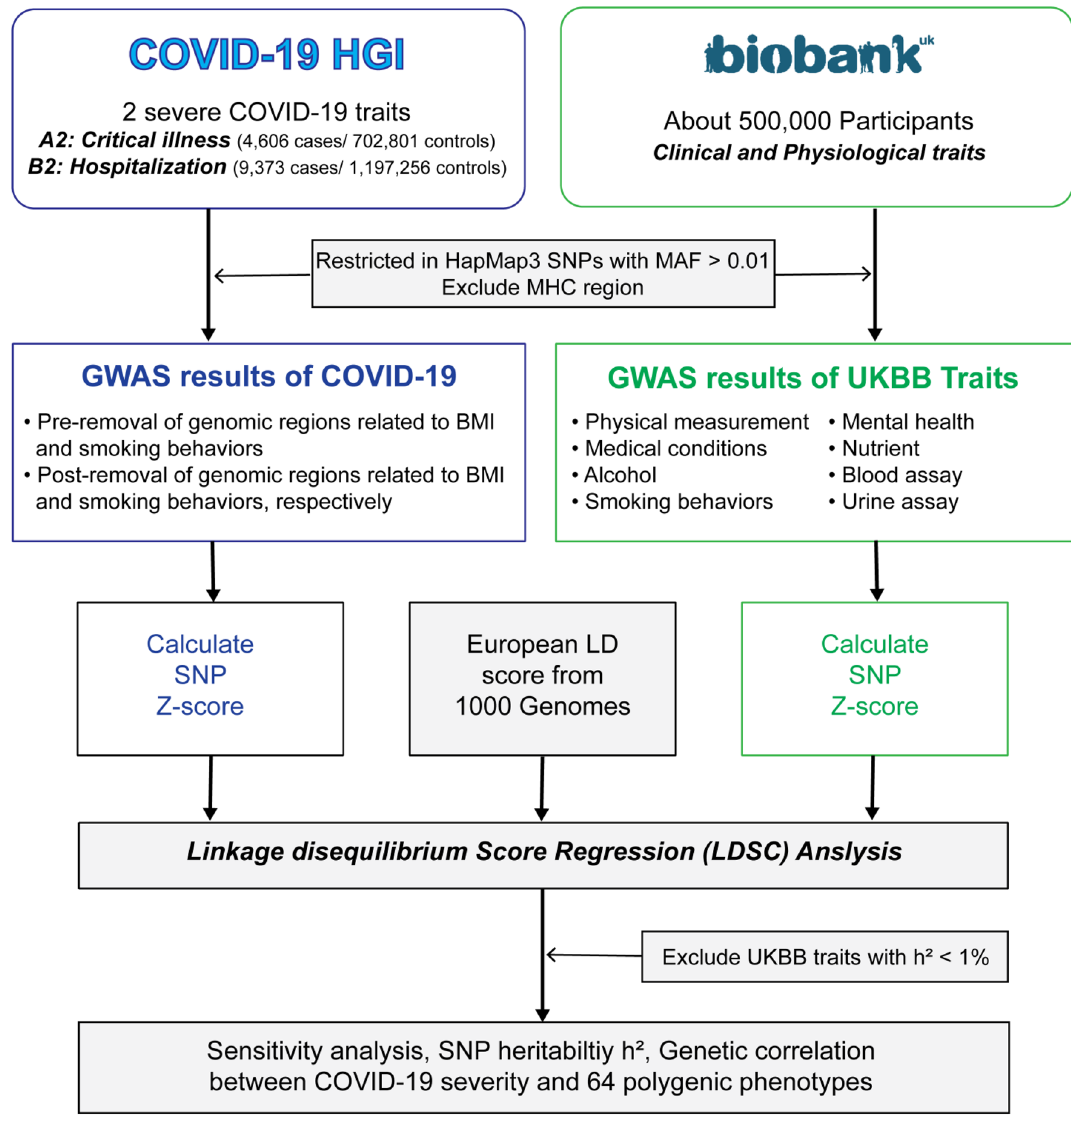
Figure 1. Flow chart of the analytical workflow in the